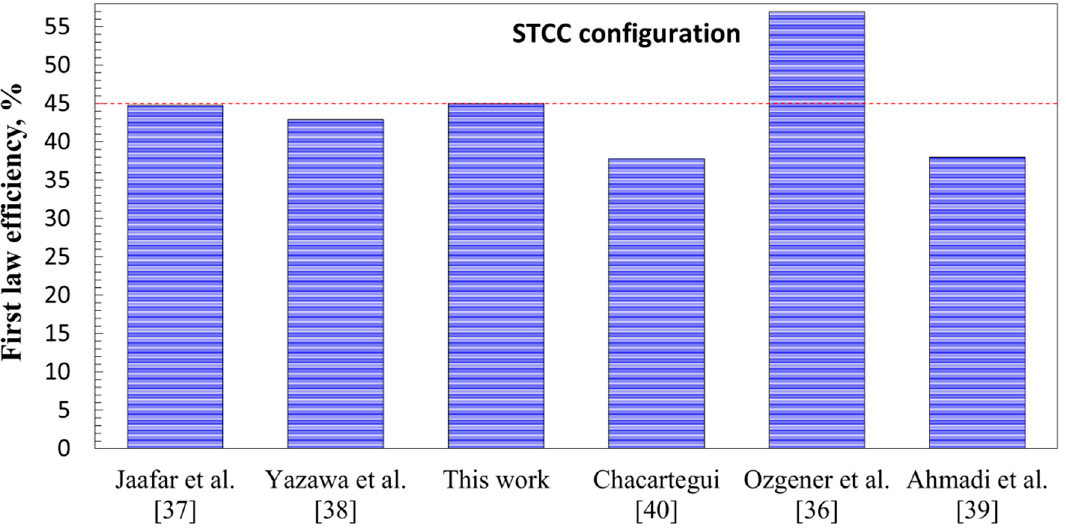
Figure 14. A rough comparison between FLE of the STCC assessed in this work and those reported in the literature